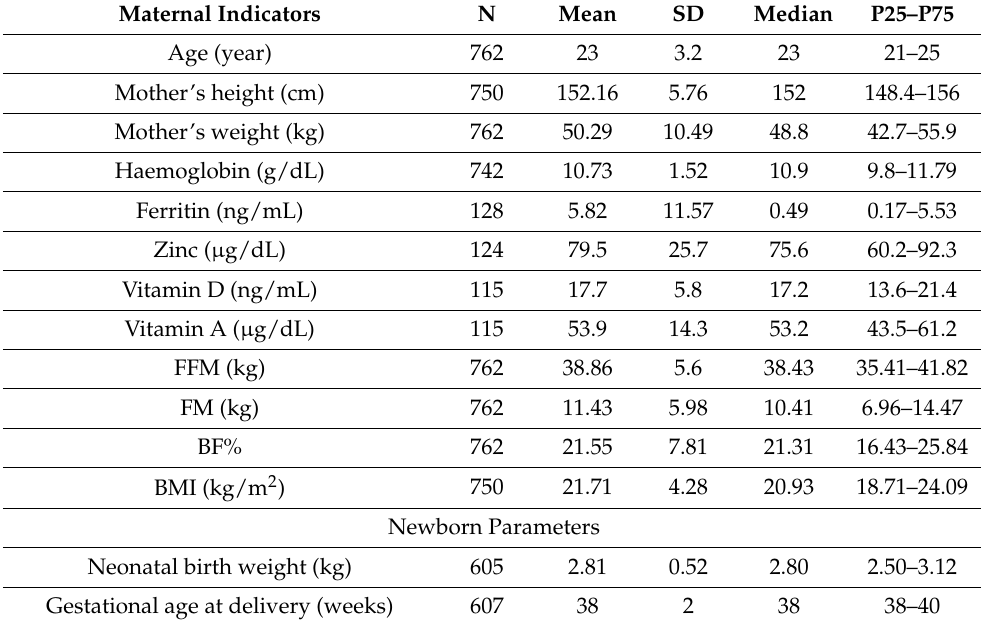
Table 2. Mean and median values of maternal anthropometry, nutritional status and newborn